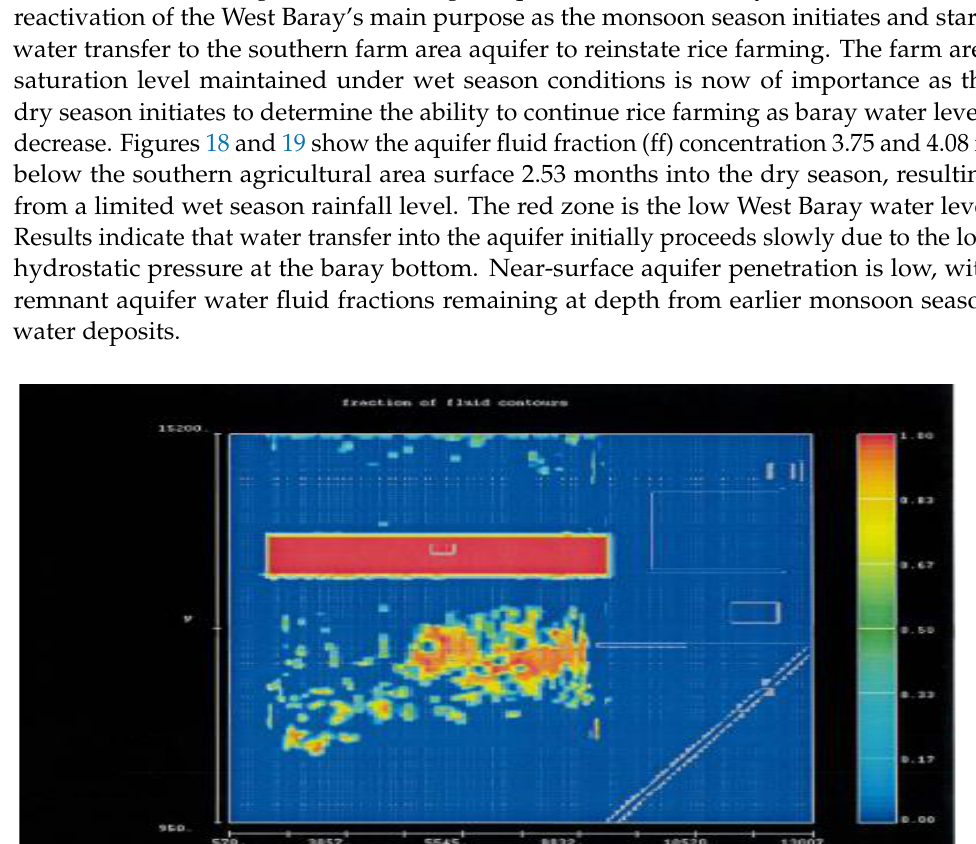
Figure 19. Aquifer fraction of fluid ff concentration at 4.08 m below the southern farm area surface 2.53 months after the monsoon season initiates. Aquifer water levels remain high at depth from earlier rainy season deposits. Color version added to [1], p. 367. As the rainy season initiates months later with baray infilling, near-surface aquifer infilling initiates (Figure 20)—this process is aided by the saturated aquifer at depth left over in the dry season, as Figures 17 and 18 indicate.